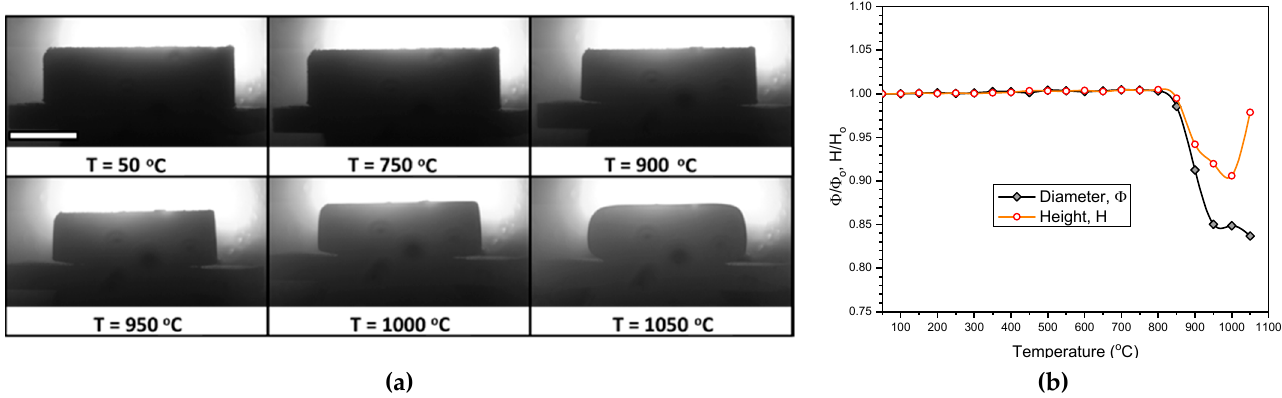
Figure 3. Heating microscopy study of a cylindrical pellet of pressed LCD glass powder: ( a ) evolution of morphology (scale bar = 5 mm); ( b ) changes in relative diameter and relative height.